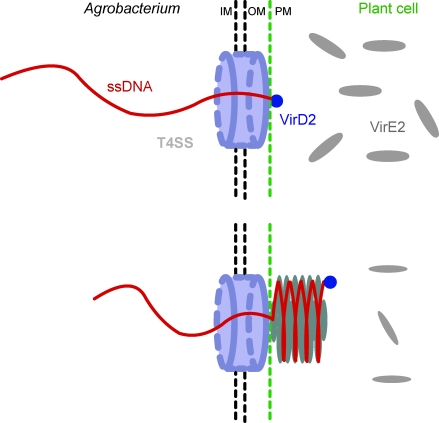
Model of T-DNA Translocation into the Plant Host CellTransferred ssDNA-VirD2 is exported out of the bacterium through a Type IV secretion system (T4SS, light blue) and reaches the host cell cytoplasm. There, the cooperative arrangement of VirE2 into a helical structure actively pulls the incoming T-DNA into the plant cell cytosol. Additionally, the large speed of polymerization (∼1 μm/s) mediates a fast protection of the T-DNA at the very moment it enters the host cytosol. IM: inner membrane, OM: outer membrane, PM: plasma membrane.